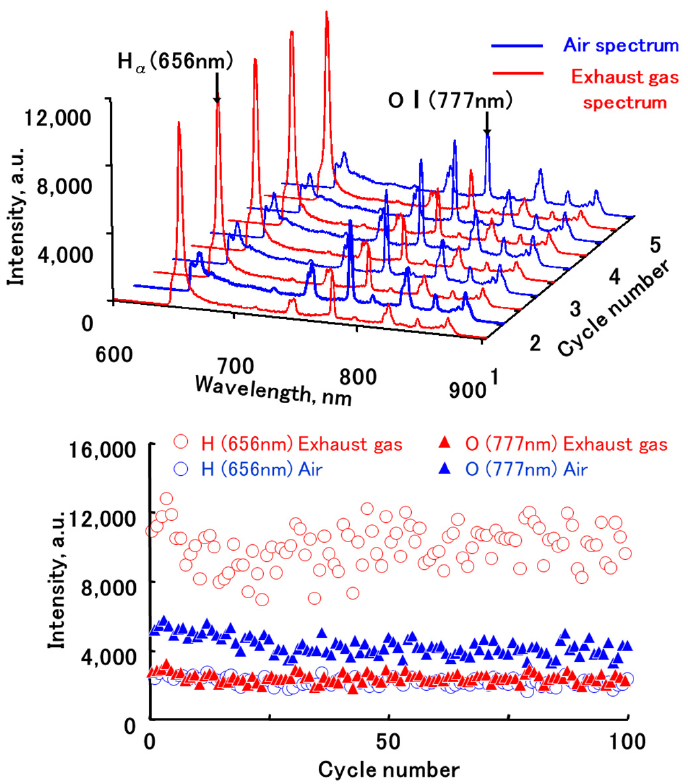
Figure 14. Cyclic variation measurement of A/F in the exhaust gas, with an A/F = 18. The O atomic spectra intensity increased in the exhaust gas.